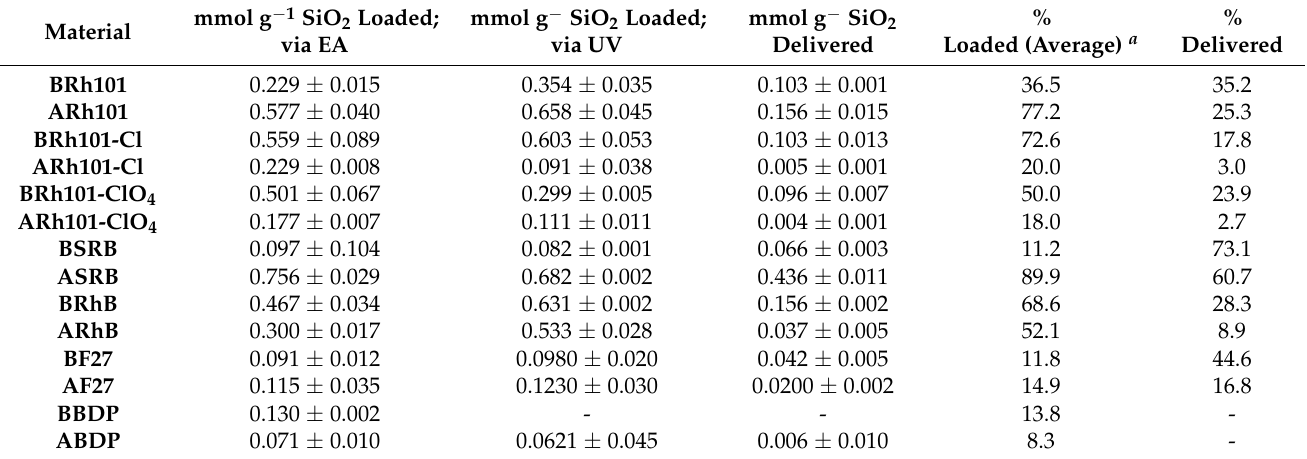
Table 3. Amount of dye (mmol g − 1 SiO 2 ) loaded into and delivered from the various materials.